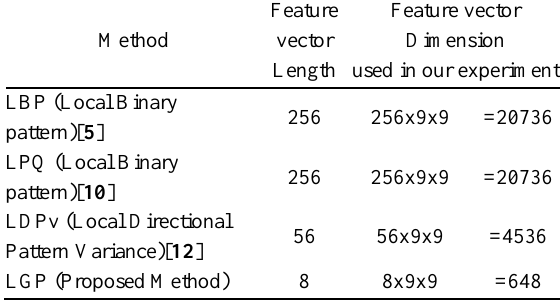
Table 1. Feature Vector Dimension of proposed methods and some other popular methods.